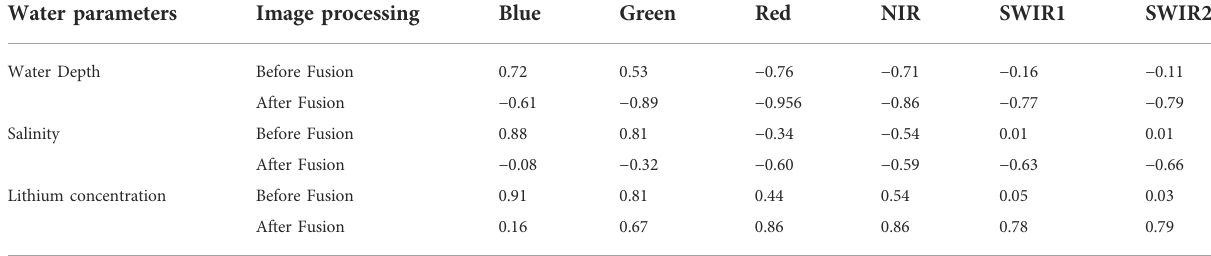
TABLE 2 The correlation between the spectral value and the water depth, salinity and lithium concentration before and after image fusion. Water parameters Image processing Blue Green Red NIR SWIR1 SWIR2 Water Depth Before Fusion